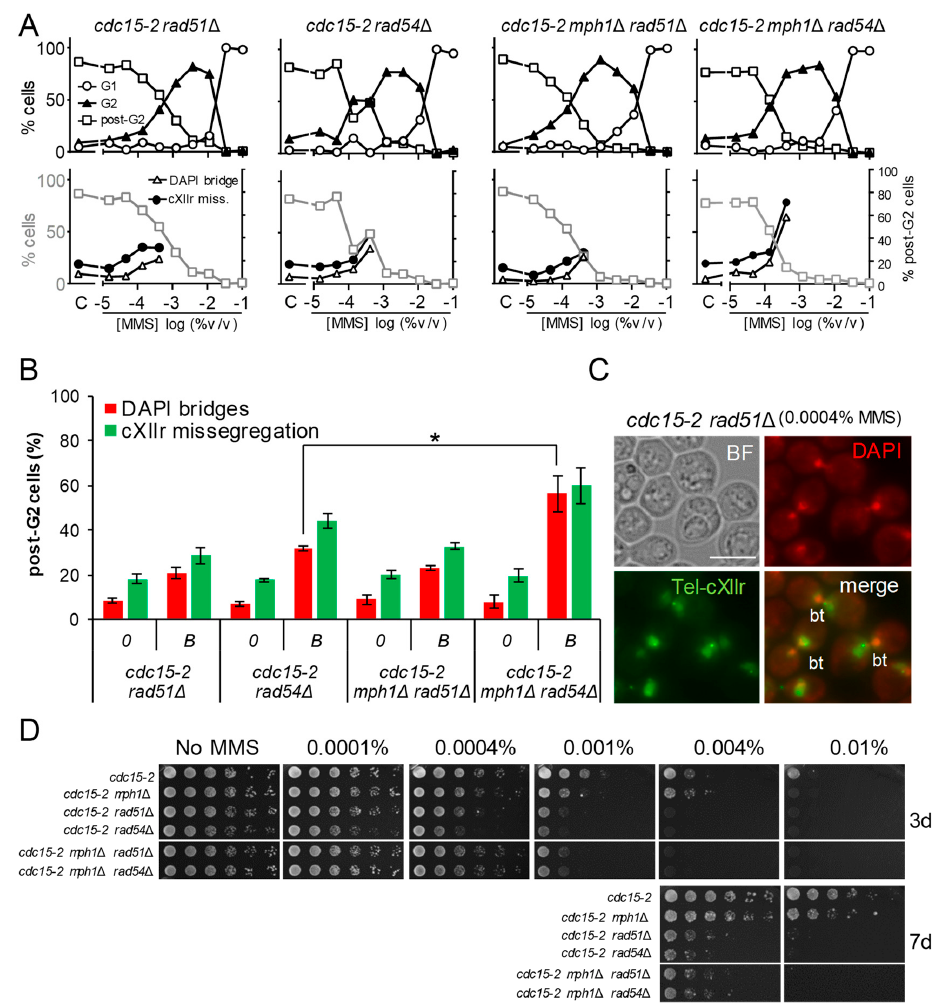
Figure 3. Deletion of MPH1 was hypostatic to rad51 Δ but additive to rad54 Δ regarding post ‐ G2 aberrant figures. ( A ) MMS dose ‐ response curves of FM588 single knocked out mutant derivatives for RAD51 and RAD54 , as well as the double mutants mph1 Δ rad51 Δ and mph1 Δ rad54 Δ . ( B ) DAPI ‐ bridges and cXIIr missegregation of three independent experiments without (“0”) or with borderline (“ B ”) MMS (mean ± SEM). B was 0.0004% v/v in all cases. The asterisk (*) highlights the comparison of percentages of DAPI bridges between rad54 Δ and mph1 Δ rad54 Δ ( p < 0.05, Student’s t test). ( C ) Micrographs of representative rad51 Δ cells at 0.0004% v/v MMS. “bt” refers to “bow ‐ tie” phenotype: dumbbell cell with a short DAPI bridge across the budneck. Scale bars represents 5 μ m. ( D ) Long ‐ term survival (spotting assay) for the referred mutants under increasing doses of MMS.